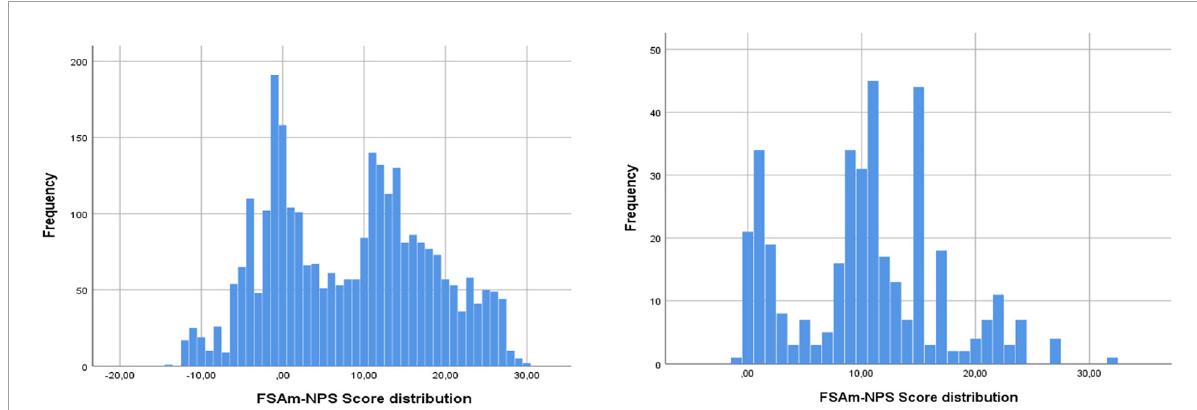
FIGURE1 Distribution of FSAm-NPS Score among branded solid foods and beverages in the He1TH FCDB ( n = 3,224).